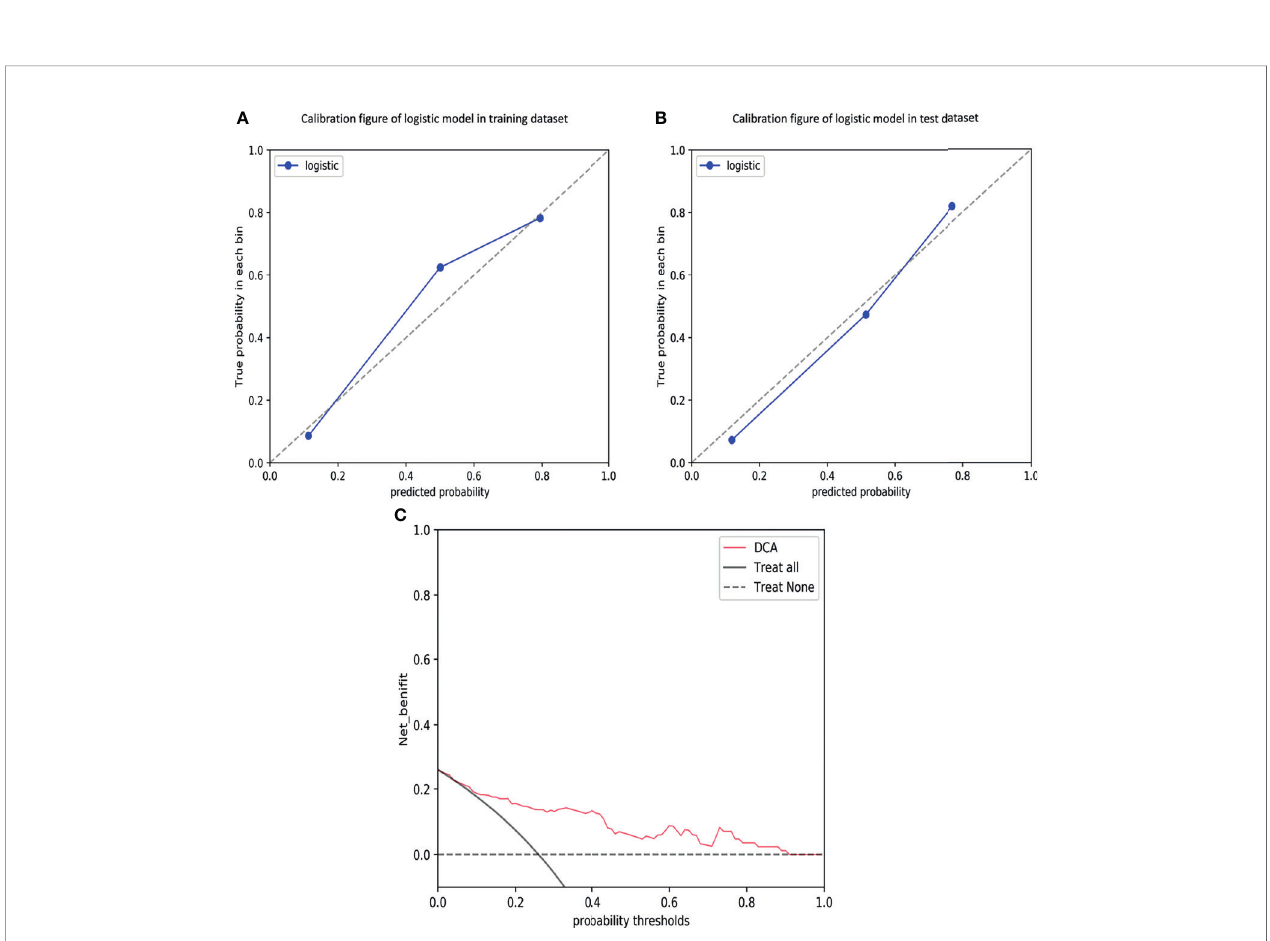
FIGURE 4 | Calibration curves of the combined model in the training (A) and test (B) datasets, demonstrating good agreement between the predictions and observations. Decision curve analysis (DCA) for predicting perineural invasion status in the test dataset (C) , indicating good discrimination.